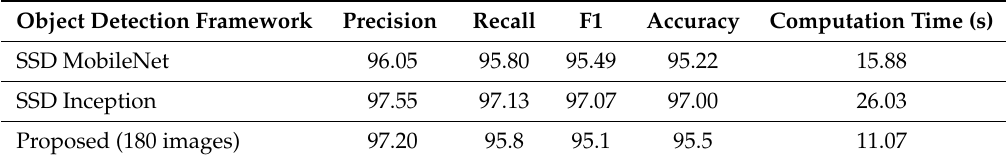
Table 3. Comparison with other object detection